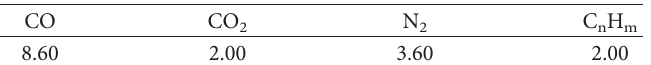
Table 4: Coke oven gas